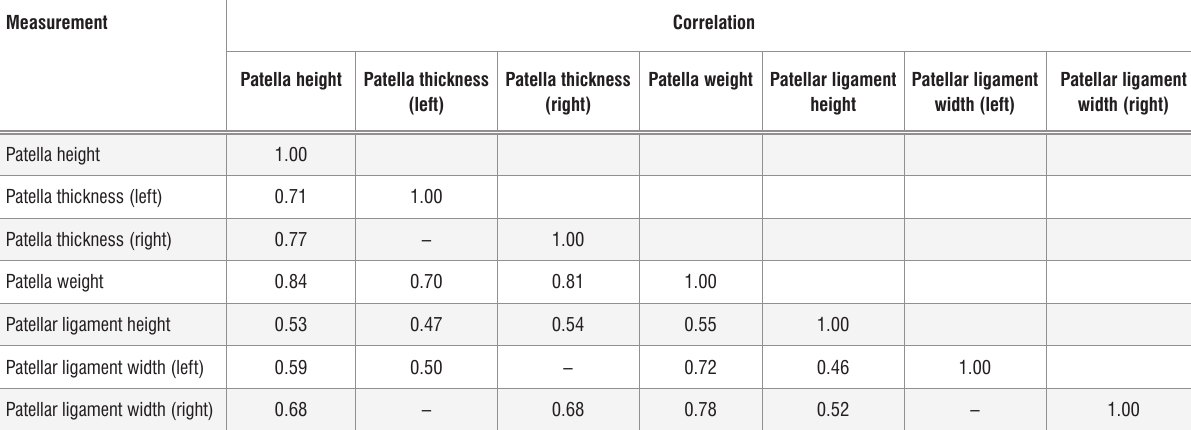
Patellar ligament height Patellar ligament width (left) Patellar ligament width (right)